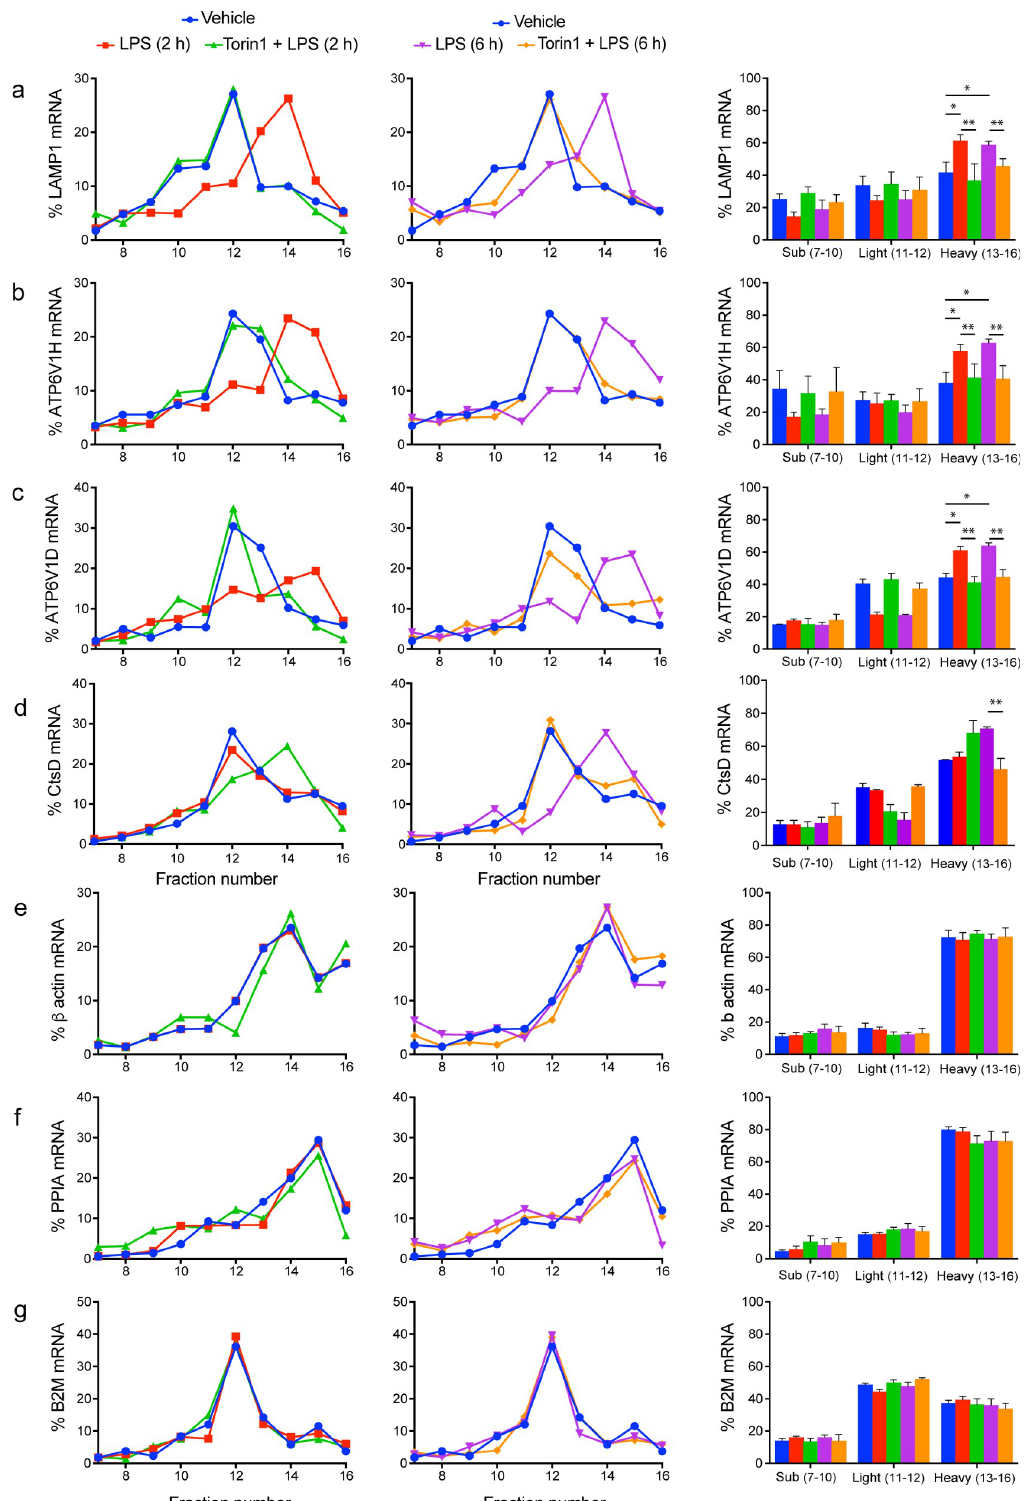
Fig 7. LPS increases translation of mRNAs encoding lysosomal proteins in an mTOR-dependent manner. (a–g) Percent of target mRNA—(a) LAMP1, (b) ATP6V1H, (c) ATP6V1D, (d) CtsD, (e) β -actin, (f) PPIA, and (g) B2M—associated with each ribosome fraction in resting, LPS- or LPS/torin1-treated RAW cells. Left and middle panels show 2 h and 6 h treatments,